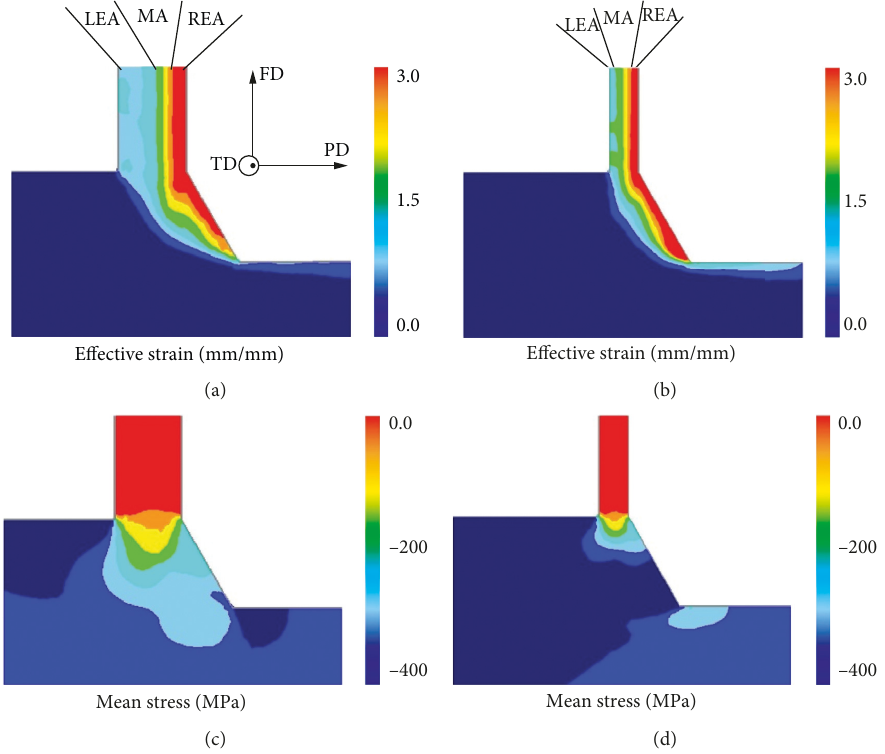
Figure 6: Results of FE simulations on strain and stress distributions for (a) and (c) t strain is 4 for both cases. LEA, MA, and REA are the left edge area, middle area, and right edge areas,